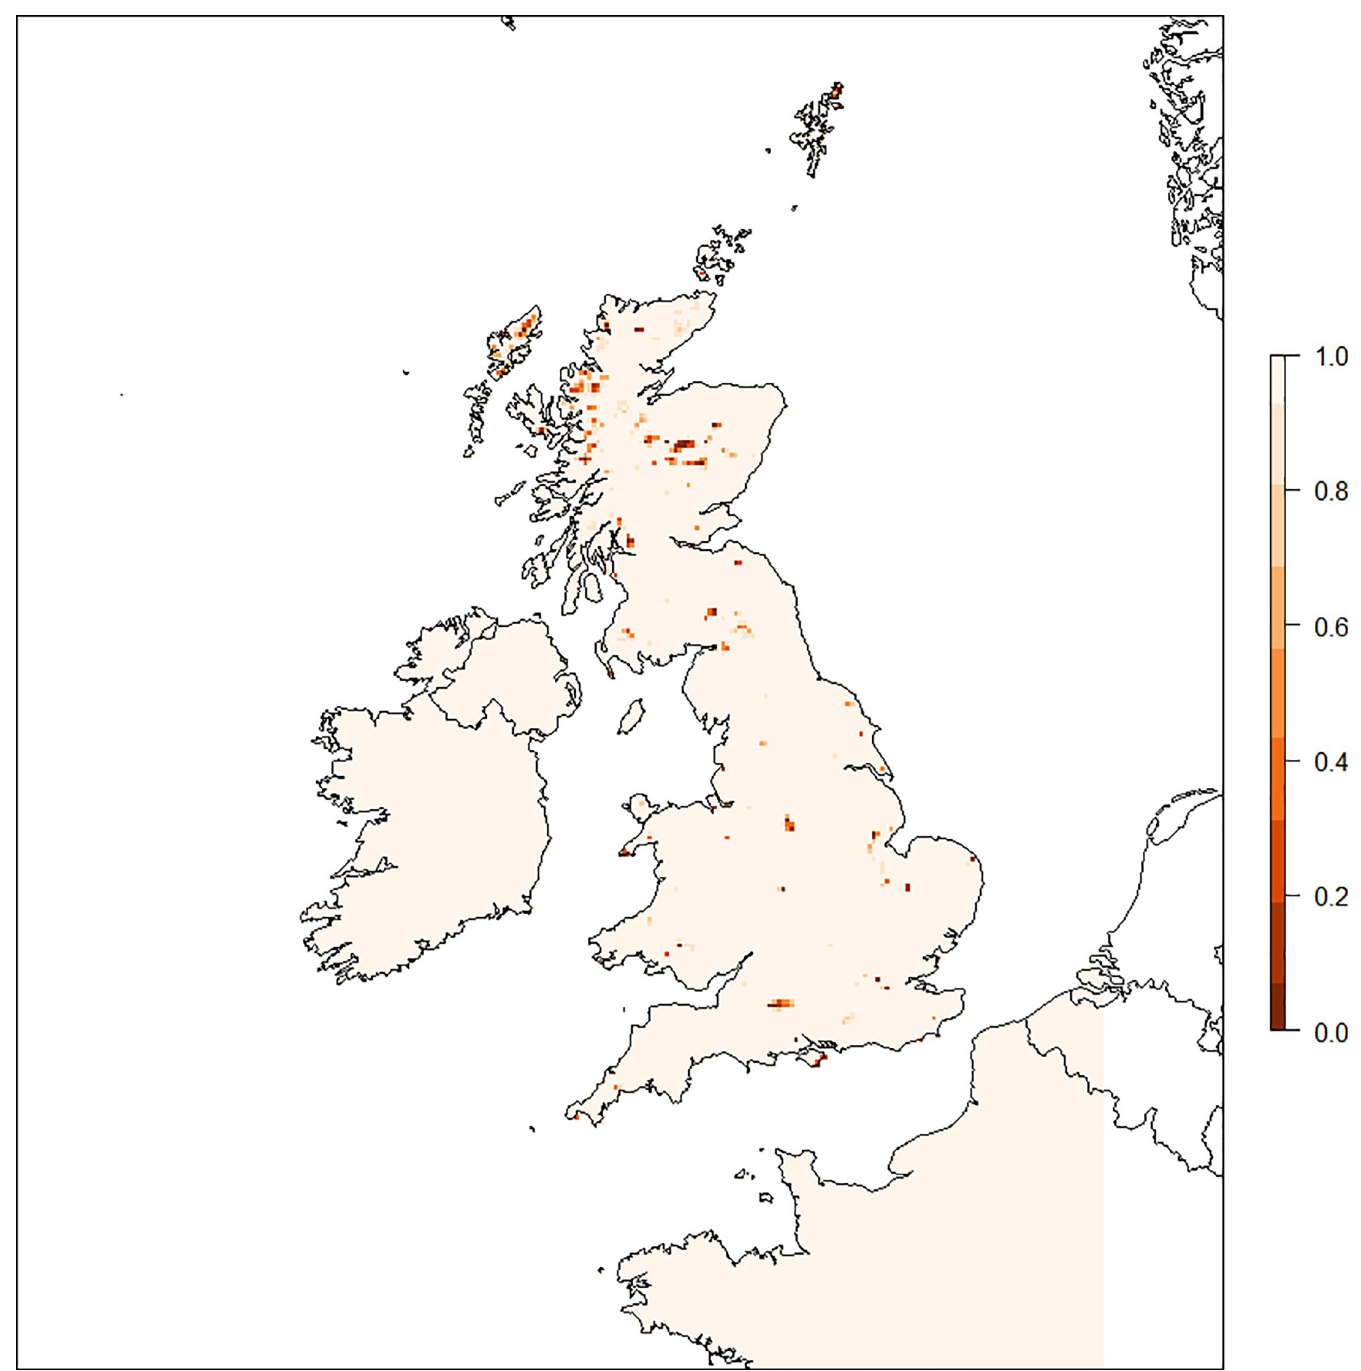
Fig 4. UK map detailing the results of the MESS analysis. The map shows the averaged result over all iterations of the model; a value close to 1 (lighter) indicates the region is described well by the training data, while a value close to zero (darker) indicates it is